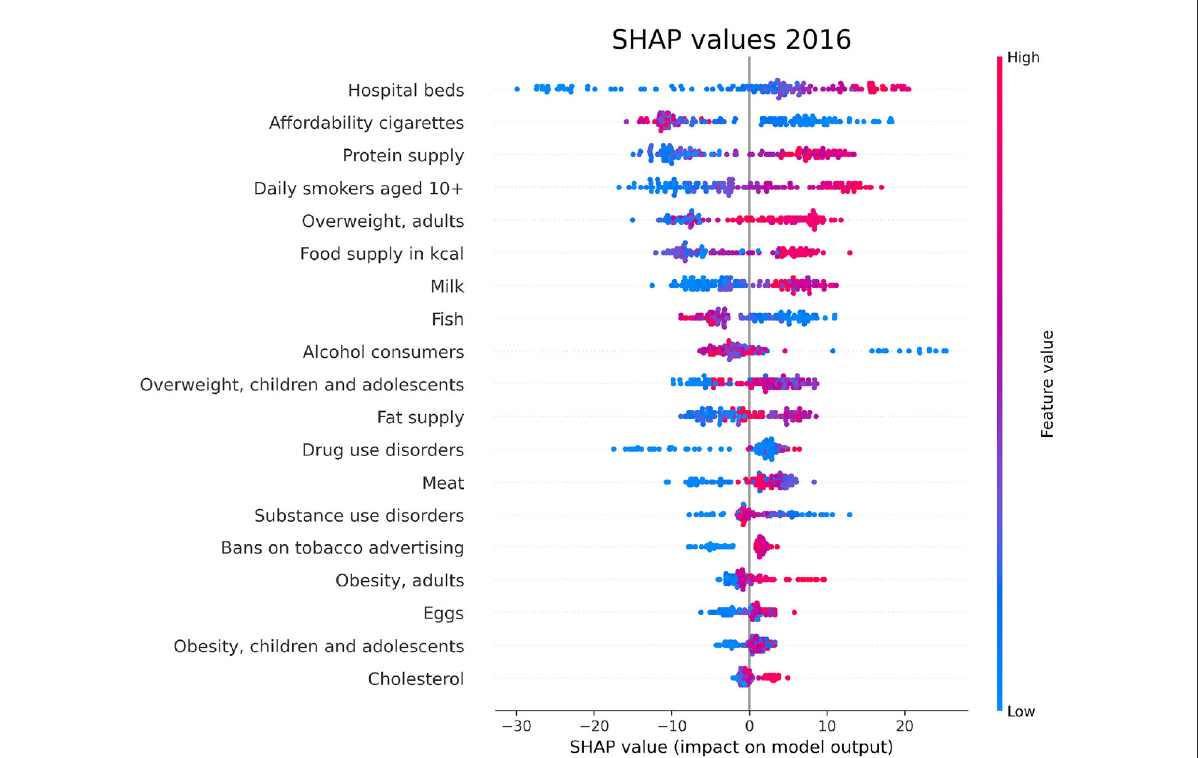
FIGURE8 SHAP values corresponding to the features that are most influential in the prediction of PAD for the year 2016. Different points in the same row are associated to the prediction made for different